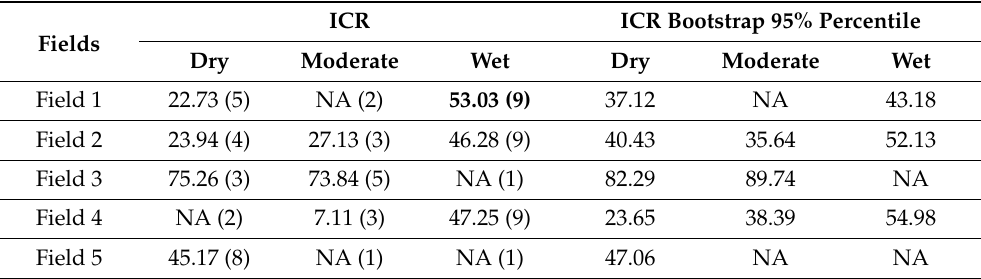
Table A1. Consistency index in different climate years when ICR group classified based on thresholds (dry years < 160 mm, moderate years = 160–240 mm, wet years > 240 mm). A number inside brackets indicate the number of years within each group. Bold values indicate marginally significant adjusted p values ( p < 0.1). NA values are indicating statistically not enough data for the analysis.